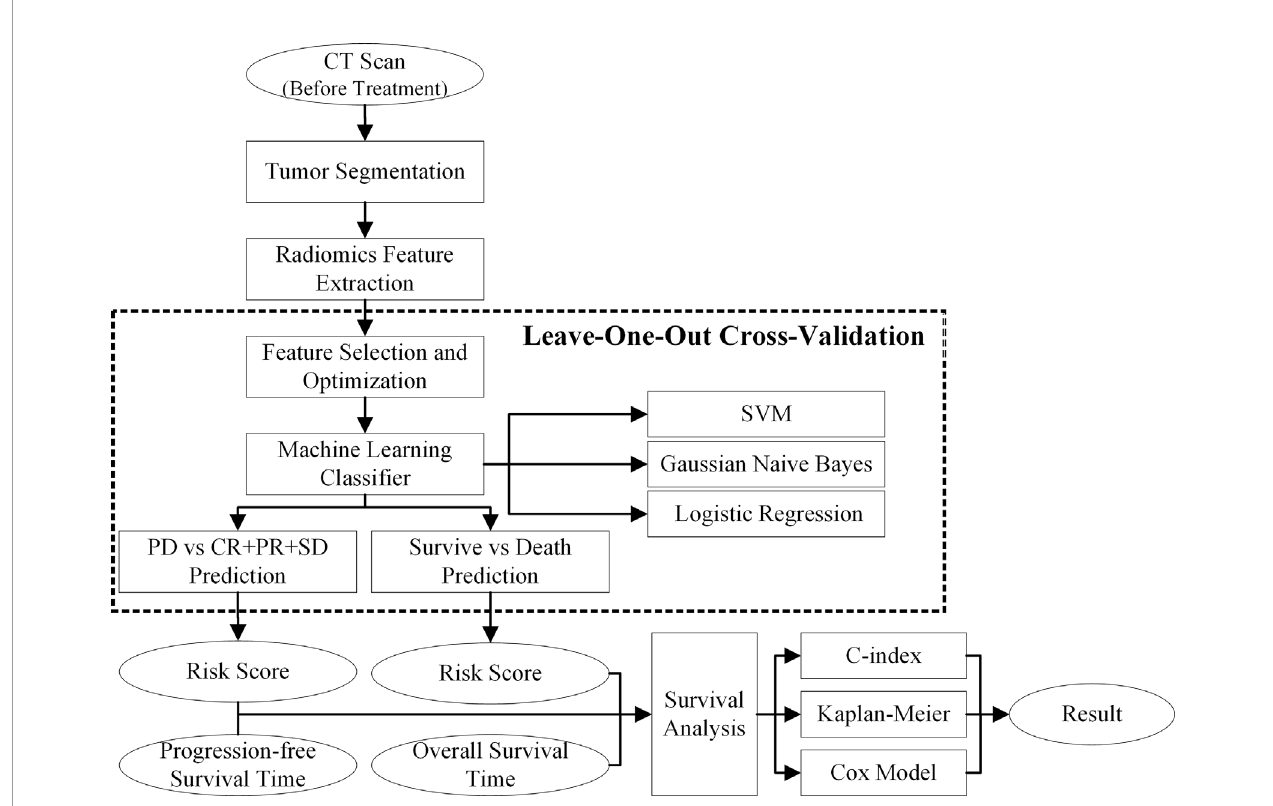
FIGURE 1 | Flowchart of our proposed